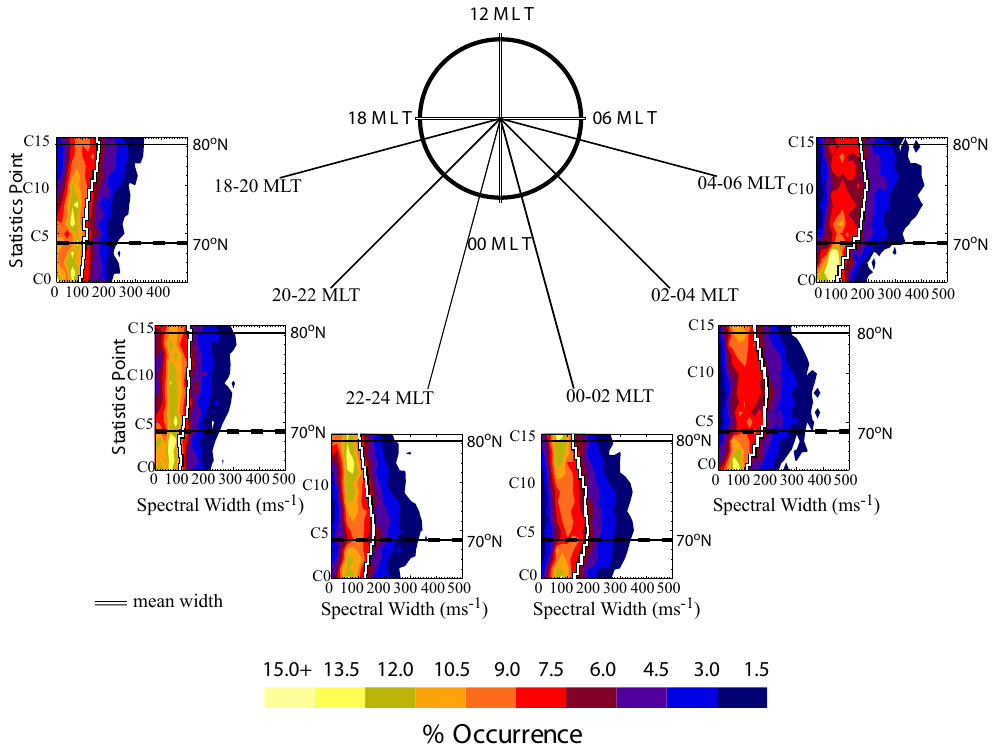
Fig. 5. Contour plots showing the Northern Hemisphere winter variation of spectral width distributions with MLT from Iceland East. The points below the black dashed line do not overlap with the conjugately mapped Syowa East summary points. The 70 ◦ N and 80 ◦ N positions are indicated by the thin black lines. The white on black lines show the mean spectral width value for each point on the lower axis scale. The colour scale indicates the occurrence at each width normalised to the total occurrence for each summary